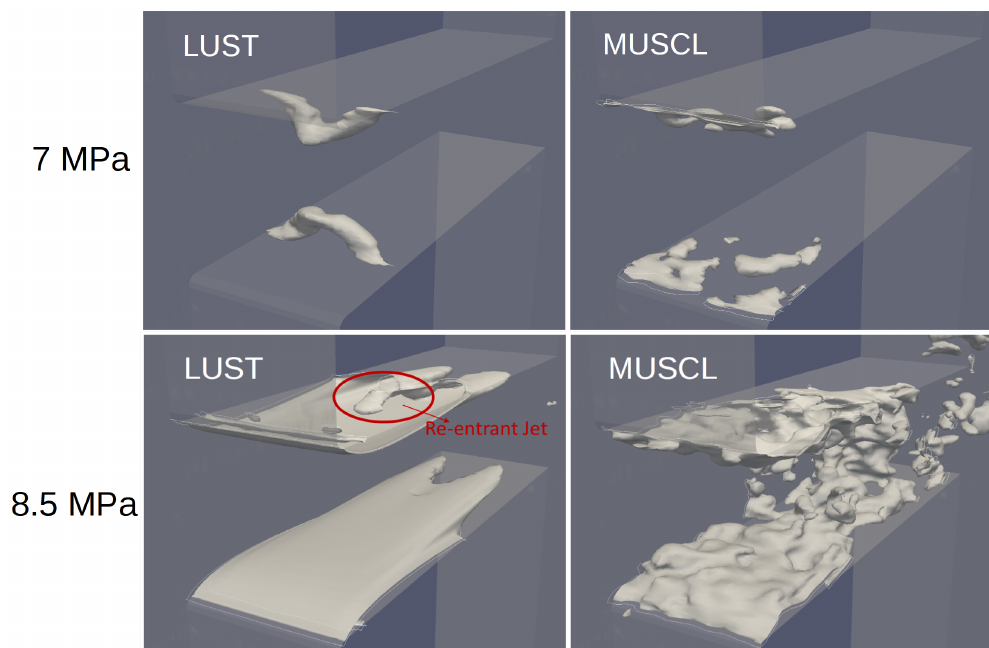
Figure 8. Three dimensional comparison of the instantaneous liquid vapour interface (iso-surface of vapour fraction is set to 0.5) of the MUSCL and LUST schemes at p dif f =7 MPa (top row) and p dif f = 8.5 MPa (bottom row) using the 12 mm downstream length, wave transmissive